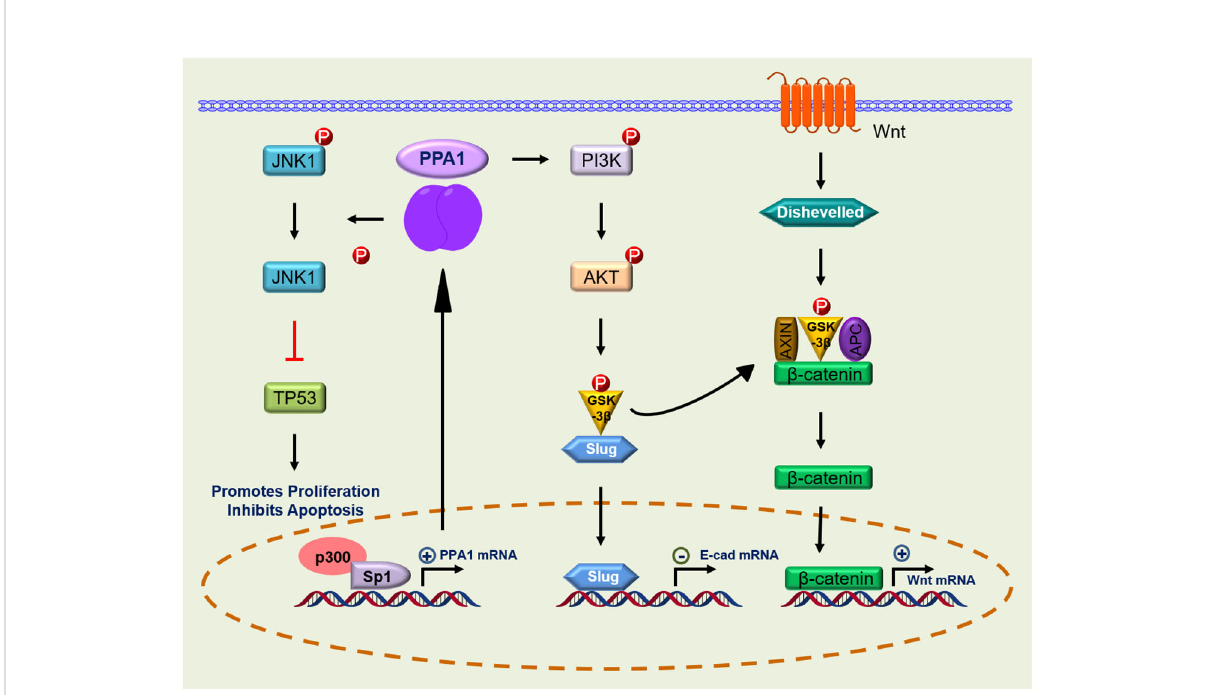
FIGURE 2 Signaling pathway of PPA1 in malignant tumor progression. PPA1, Inorganic pyrophosphatase; JNK-1, c-Jun N-terminal kinase 1; p53, p53 tumor suppressor homolog; p300, Histone acetyltransferase; Sp1, Sp1 transcription factor; PI3K, Phosphatidylinositol 3-kinase; AKT, AKT serine/